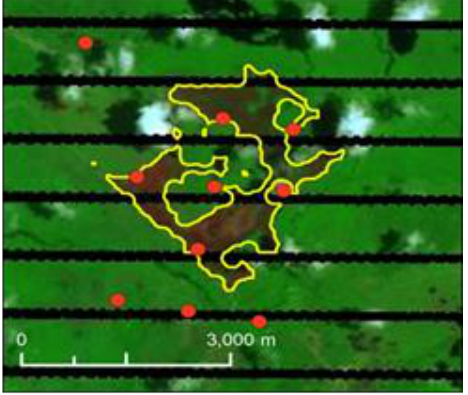
Figure 2. Example of 925 acre burned area polygon derived from Landsat scene dated 7/6/2012 and corresponding HMS fire detections from